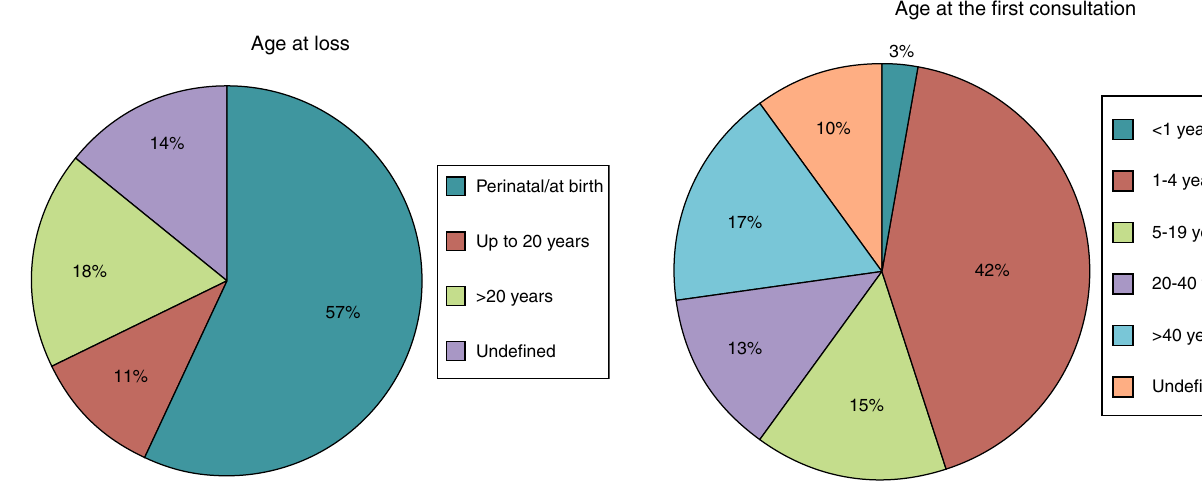
Percentage distribution of patients evaluated in the cochlear implant outpatient clinic according to age at the first